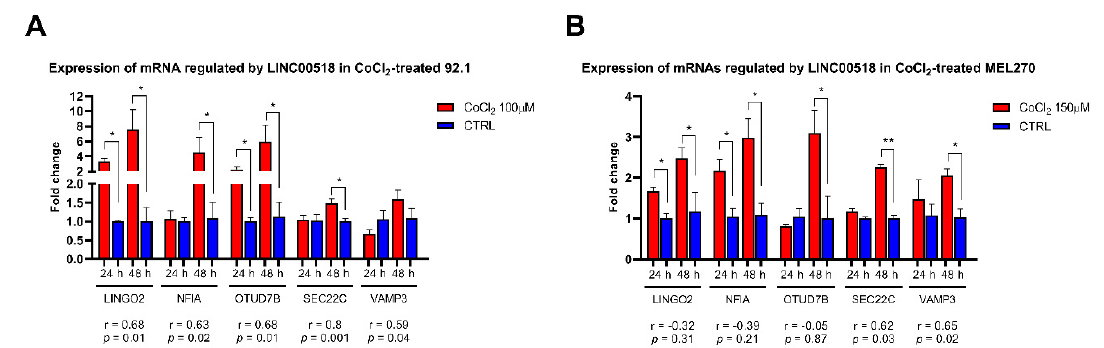
Figure 9. Expression of mRNAs regulated by LINC00518 after HIF1A activation in UM cells. For each mRNA, the r-value and the associated p -value measuring correlation of expression with LINC00518 are reported. Each experiment was performed in three in vitro replicates. *: p -value < 0.05; **: p -value < 0.005.